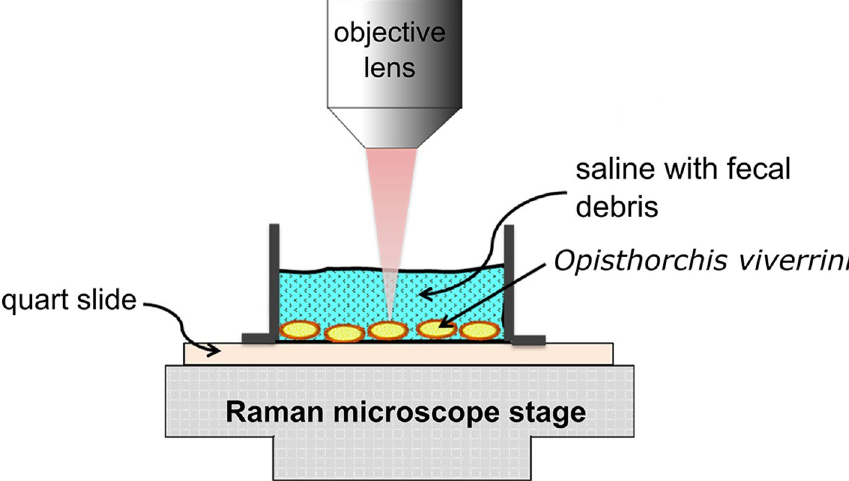
Fig 1. Experimental setup for confocal Raman analysis of Opisthorchis viverrini eggs in fecal specimens. A fecal specimen containing O . viverrini eggs was dropped onto a quartz-bottom well. Confocal Raman measurements of each O . viverrini egg were acquired while the saline overlayer remained in